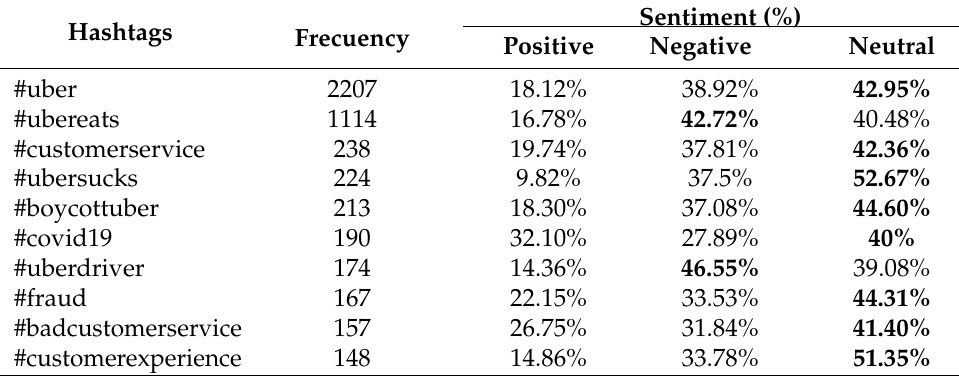
Table 1. Hashtags frequency and sentiment